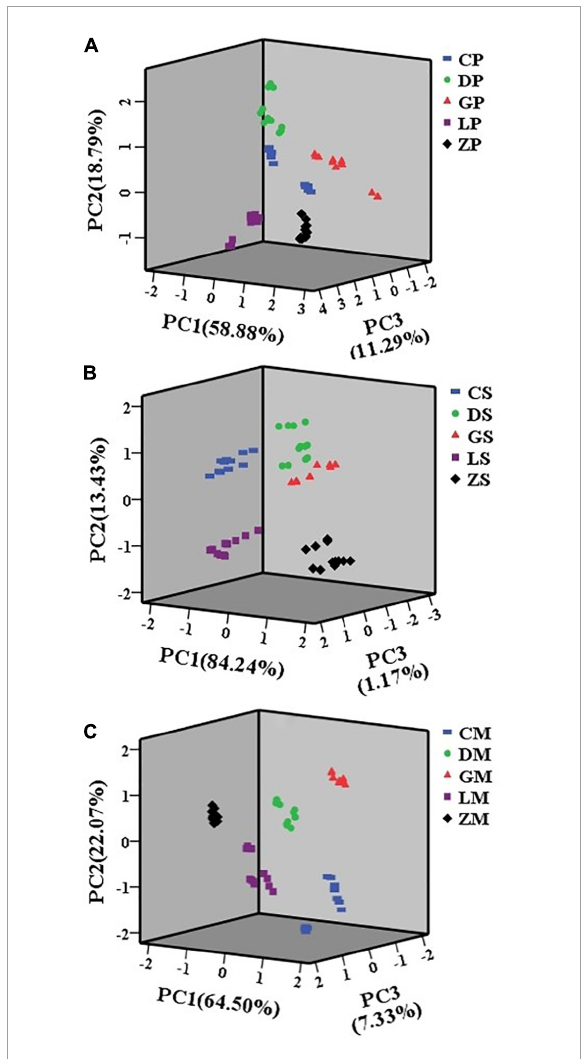
FIGURE3 Principal component analysis (PCA) plots of seasoning powder (A) , seasoning mixture sauce (B) , and the mixture of powder and sauce (C) using